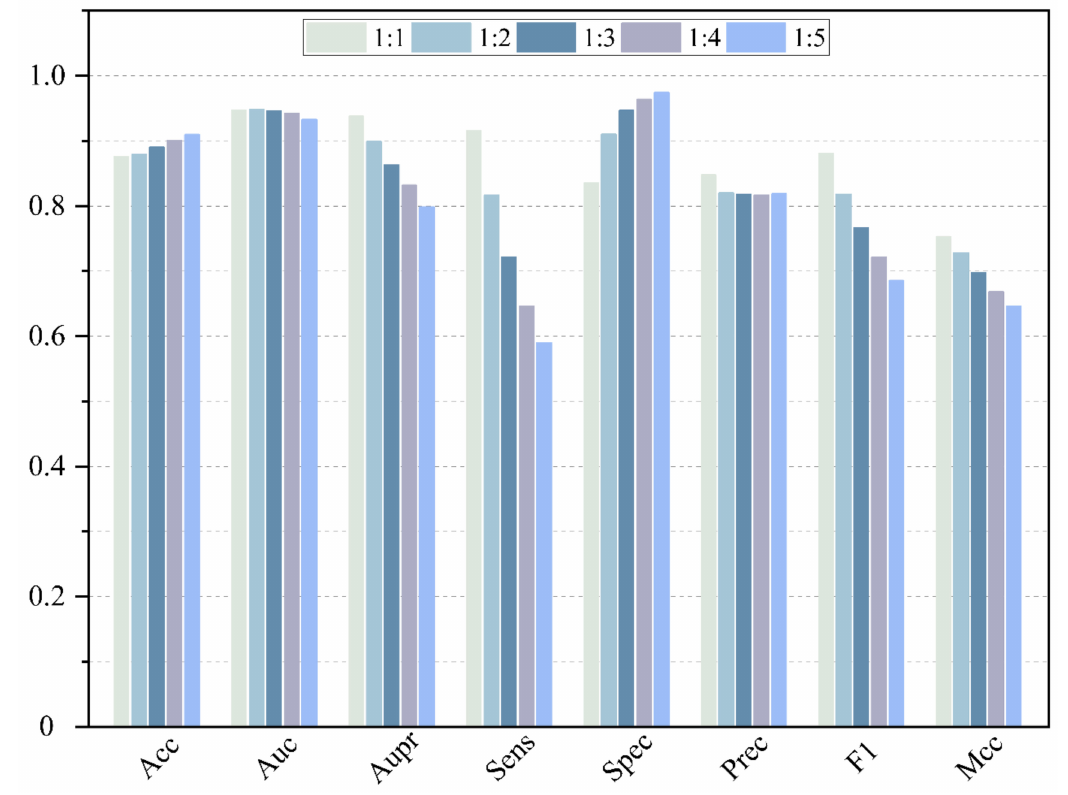
Figure 9. Performance comparison of different ratio of positive and negative